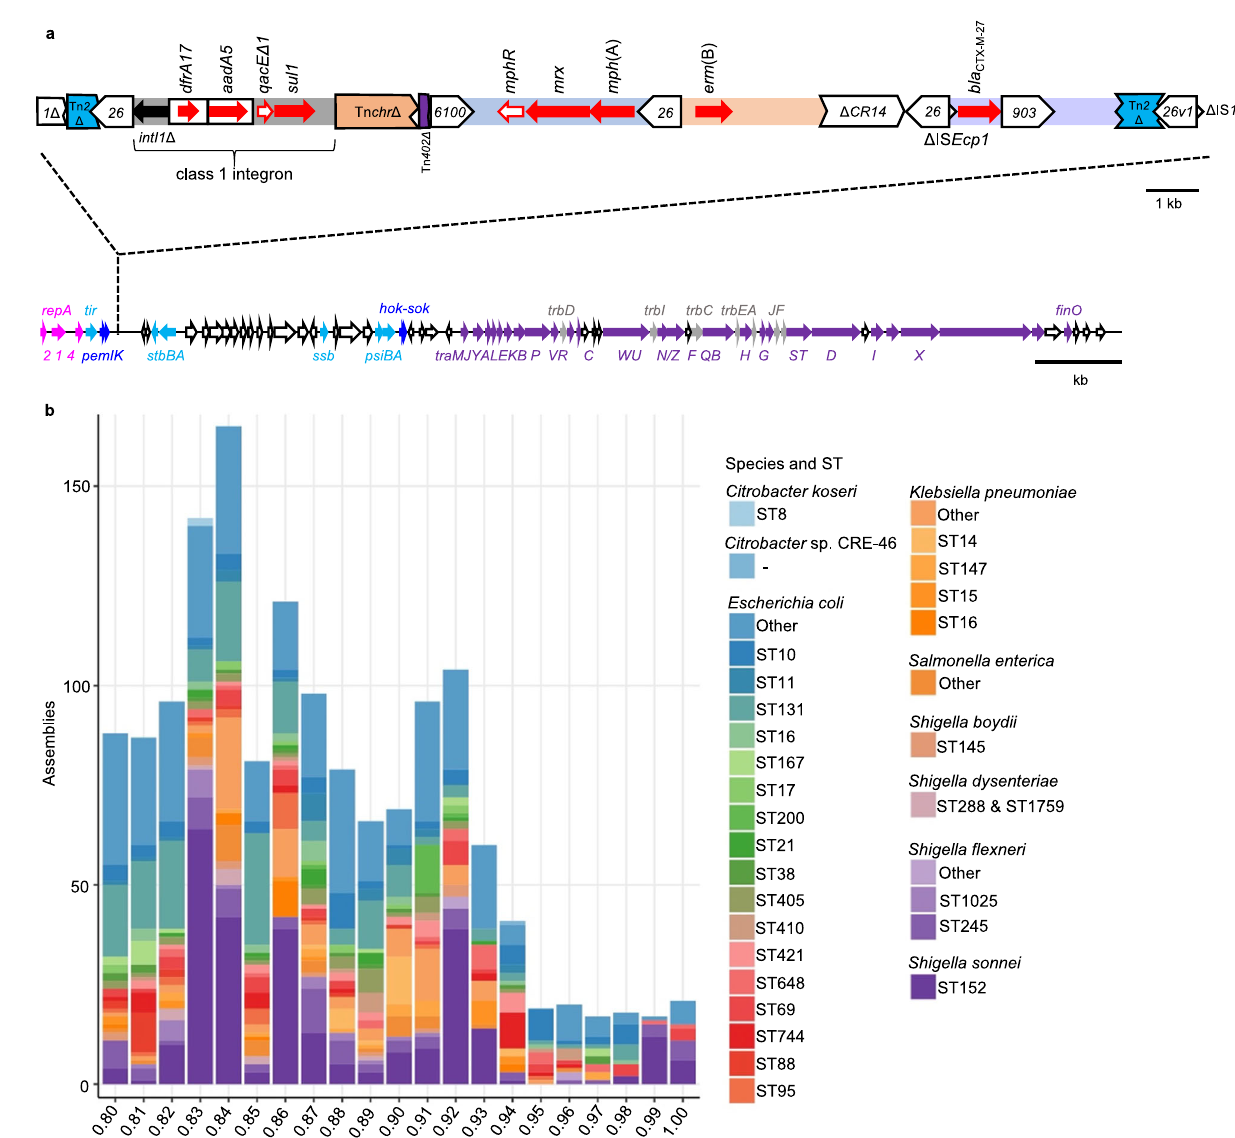
Fig. 3 | Organisation and distribution of p893816-like plasmids. a Organisation of p893816-like plasmids. The lengths and directions of transcription of various genes are shown as arrows. The upper track shows the resistance region. AMR genes indicated by solid red arrows, with resistance-related genes outlined in red. The boxes around dfrA17 and aadA5 represent the gene cassettes that carry these genes. Block arrows in white indicate various insertion sequences (IS), named/ numbered as labelled, and the direction of their transposase gene. Fragments of different transposons (Tn) are shown as interrupted blocks in different colours (blue, purple, orange) and labelledby name, and a class 1 integron is also shownin grey and labelled. The lower track shows the plasmid backbone, with the AMR